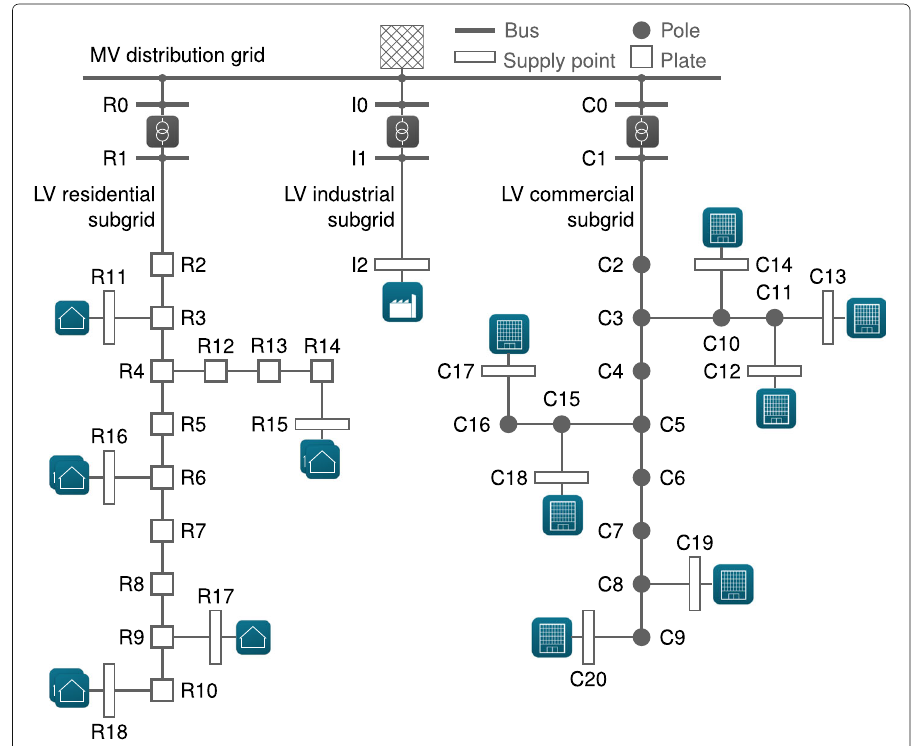
Fig. 3 The CIGRE LV benchmark grid, inspired by: https://github.com/lthurner/pandapower/blob/v1.3.0/ doc/pics/cigre_network_lv.png